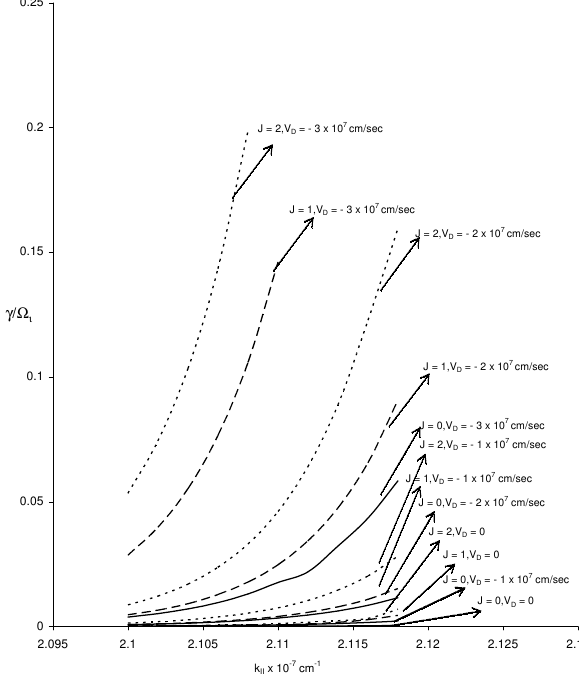
00.050.10.150.20.25 Fig. 1. Variation of growth rate ( γ / (cid:127) i ) versus wave vector k II cm − 1 for different values of ion beam velocity V D , and dis- Fig.1 Variation of growth rate ( g / W i ) versus wave vector k II cm -1 for different tribution index J=0, 1, 2, values of ion beam velocity V D , and distribution index J=0,1,2, A=15